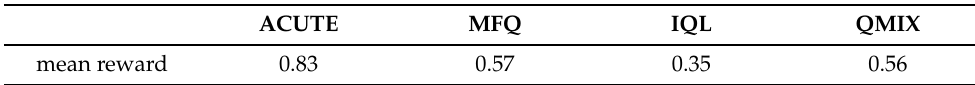
Figure 5. Experiment result in lbforaging: 8 × 8-2p-2f. Table 3. Mean reward per episode on lbforaging: 8 × 8-2p-2f.